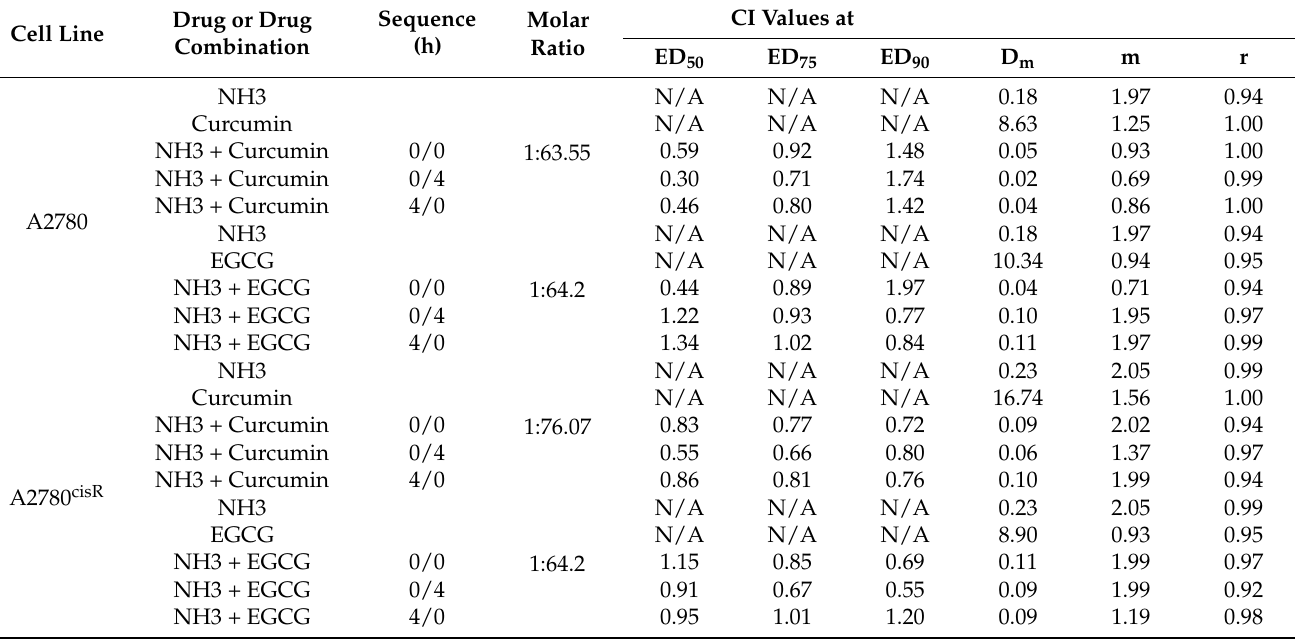
Table 7. CI values (at ED 50 , ED 75 , ED 90 ) and dose-effect parameters (median effect dose Dm, the exponent defining the shape of the dose–effect curve m, correlation coefficient r) applying to combinations of NH3 with curcumin and EGCG in the A2780 and A2780 cisR cell